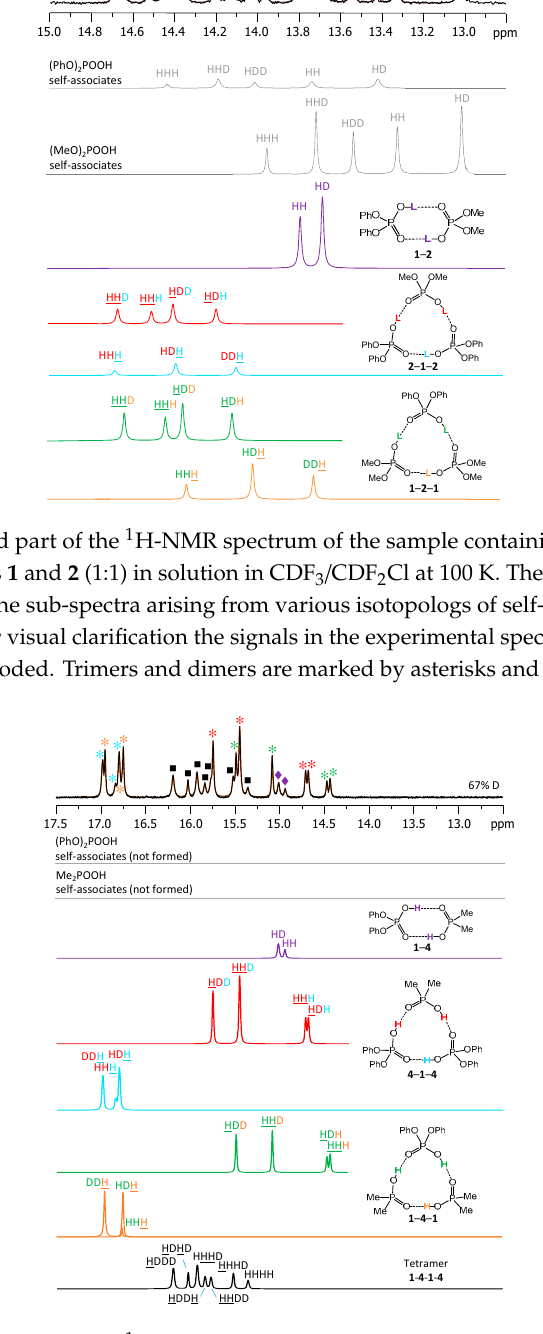
Figure 6. The low-field part of the 1 H-NMR spectrum of the sample containing partially deuterated (OH/OD, 67% D) acids 1 and 4 (1.2:1) in solution in CDF 3 /CDF 2 Cl at 100 K. The experimental spectrum is deconvoluted into the sub-spectra arising from various isotopologs of self-associates, heterodimer, heterotrimers, and a heterotetramer. For visual clarification the signals in the experimental spectrum and the computed sub-spectra are color coded.